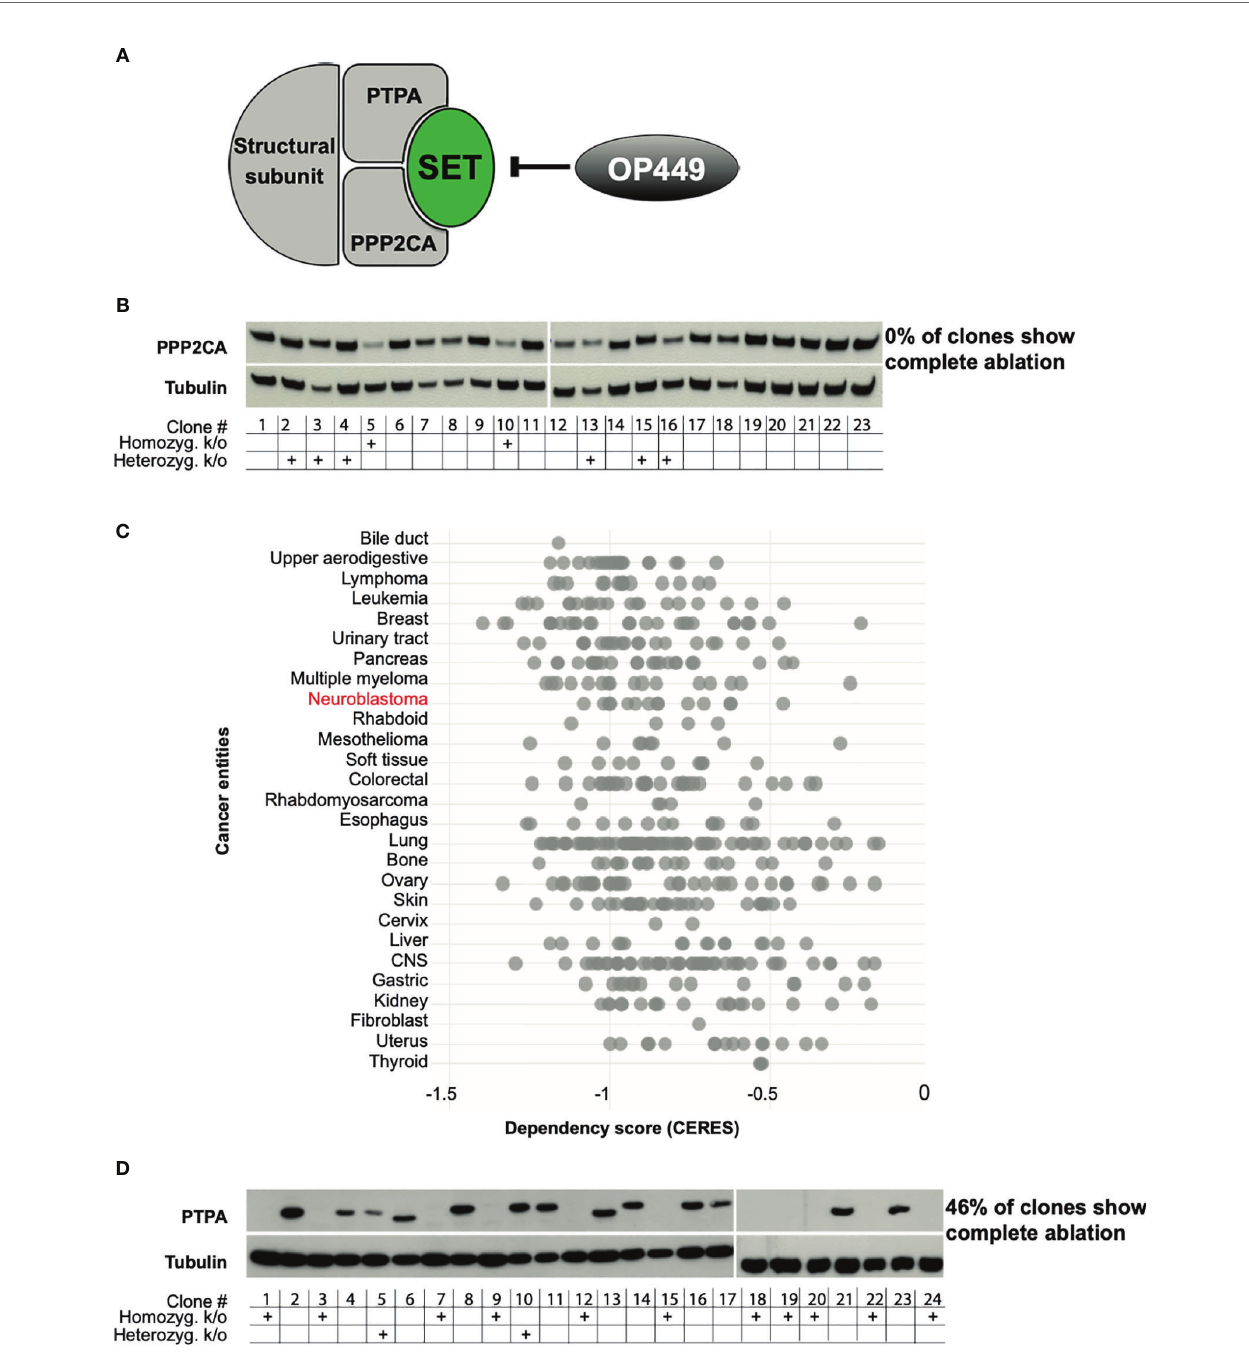
FIGURE 1 | PPP2CA, but not PTPA, is an essential survival gene for neuroblastoma (NB) cells. (A) Structure of PP2A with the subunits PPP2CA and PTPA, the PP2A inhibitor SET, and the SET inhibitor OP449. (B) KELLY NB cells do not tolerate complete lack of PPP2CA. Cells were transfected with a vector expressing guiding RNA against PPP2CA and expressing Cas9. Single cell-derived clones were analyzed. Expression of PPP2CA was assessed by Western blotting, with tubulin as loading control. The presence of the PPP2CA alleles, or its homozygous or heterozygous knock-out, was determined by Sanger sequencing. (C) Additional NB cell lines do not tolerate complete lack of PPP2CA . In silico analysis of genome-scale CRISPR/Cas9 knock-out screens of cancer cell lines including NB using the DepMap database (https://depmap.org/portal/) (18 – 20). A negative CERES score indicates that a gene is essential for survival. (D) KELLY NB cells tolerate complete lack of PTPA. Cells were transfected with a vector expressing guiding RNA against PTPA and expressing Cas9. Expression of PTPA in single clones was assessed by Western blotting, with tubulin as control. The presence of the PTPA alleles, or its homozygous or heterozygous knock-out, was determined by Sanger